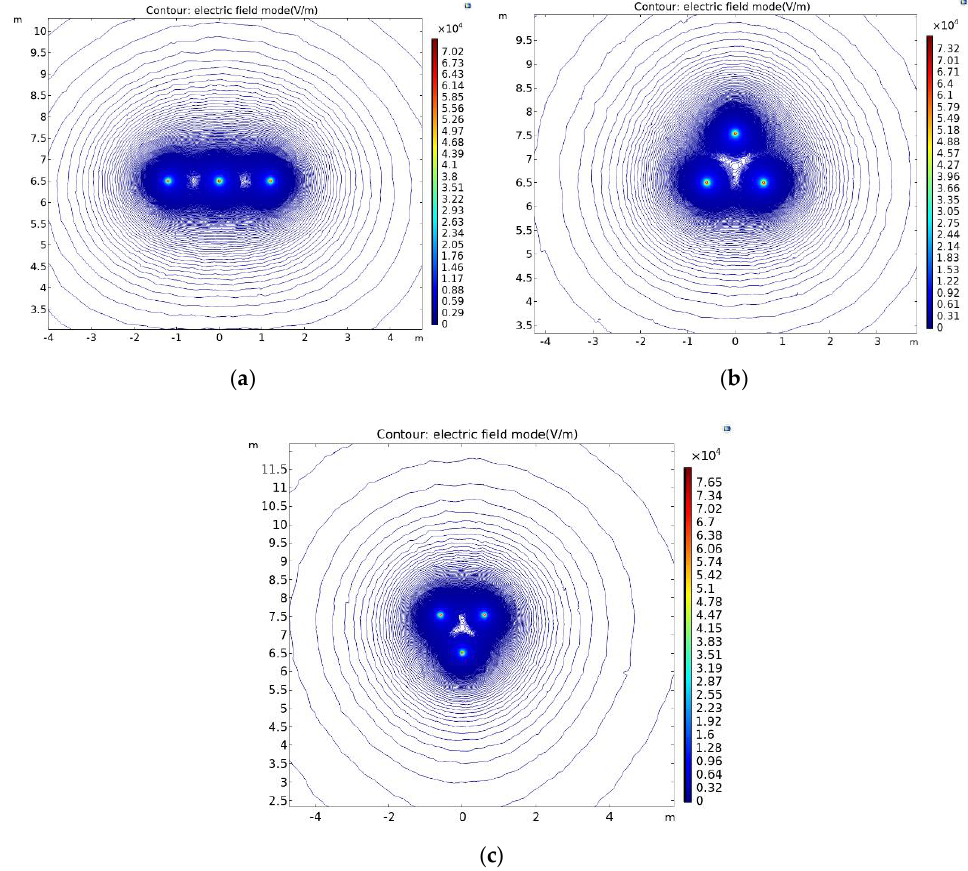
Figure 9. Electric field distribution in different arrangements: ( a ) Horizontally arranged electric field distribution; ( b ) Triangularly arranged electric field distribution;( c ) Inverted triangular arrangement of the electric field distribution.